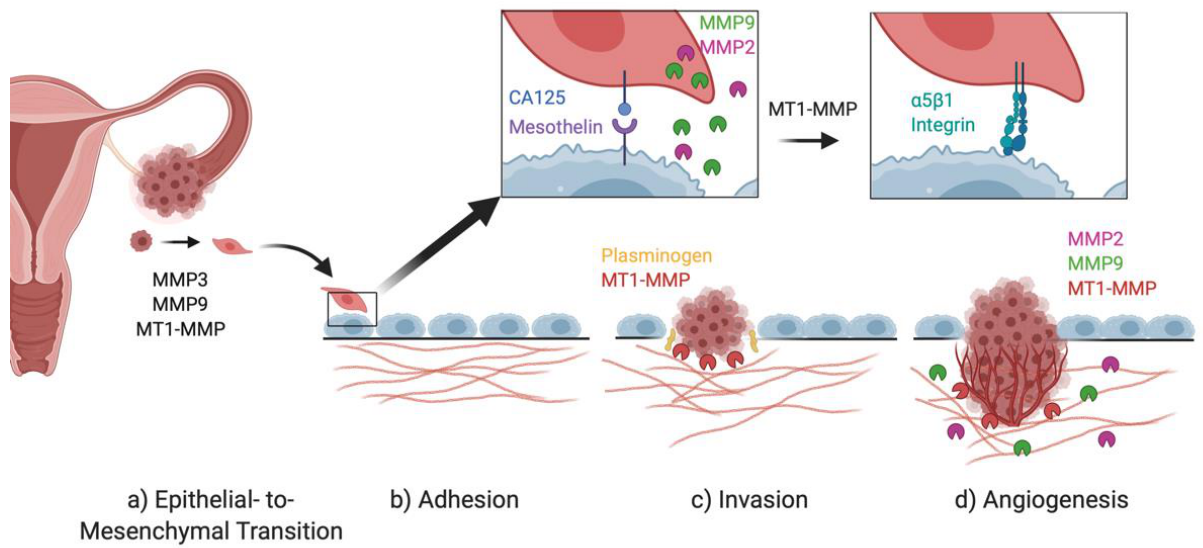
Figure 4. ( a ) Epithelial-to-mesenchymal transition (EMT), mediated by MMP-3, MMP-9, and MT1-MMP, promotes tumor cell detachment from the primary tumor, resulting in diffusion of cancer cells into the peritoneal cavity [44,52], where they ( b ) adhere to the mesothelial monolayer via binding of CA125 on the cancer cell by mesothelin on the mesothelial cell [57]. MMP-9 and MMP-2 are secreted by the cancer cell to cleave fibronectin produced by the mesothelial cell [24]. CA125 is cleaved by MT1-MMP to allow for integrin-mediated adhesion to the fibronectin fragments on the mesothelial cell and to induce mesothelial cell retraction [57]. ( c ) The basement membrane is degraded by MMPs and plasmin and the sub-mesothelial collagen matrix is remodeled by MT1-MMP [72,74]. ( d ) VEGF-mediated angiogenesis is promoted by MT1-MMP, MMP-9, and MMP-2 [83,85,86].